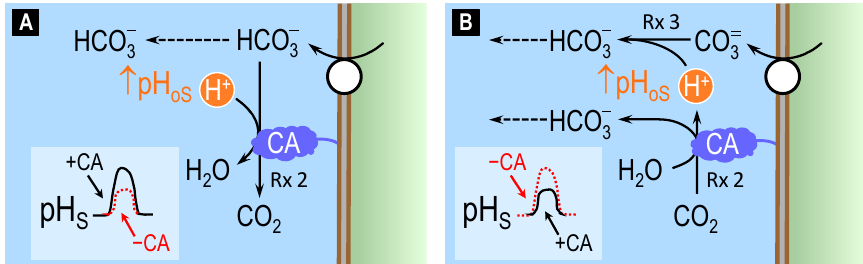
Figure 6. Theory of bicarbonate vs. carbonate efflux across cell membranes. ( A ) The exit of HCO 3 − leads to the consumption of H + (i.e., an increase in pH oS ; inset, lower left corner: solid black trace) via the CA ‐ catalyzed reaction HCO 3 − + H + → CO 2 + H 2 O (indicated as ‘Rx 2 ′ ) at the outer surface (oS) of the cell membrane. Blocking CA (i.e., applying a CA inhibitor) reduces H + consumption (i.e., the rise in pH oS ; dashed red trace). ( B ) The exit of CO 32 − leads to the consumption of H + (i.e., an increase in pH oS ; solid black trace) via the reaction CO 32 − + H + → HCO 3 − (indicated as ‘Rx 3 ′ ) at the outer surface of the cell membrane. Blocking CA (i.e., applying a CA inhibitor) reduces production of H + (by ‘Rx 2 ′ ) for subsequent consumption via ‘Rx 3 ′ . Thus, CA inhibition amplifies the rise in pH oS (dashed red trace). Rx = reaction; the number following the abbreviation ‘Rx’ indicates the number ‐ ing of the reaction in the main text. CA = carbonic anhydrase.